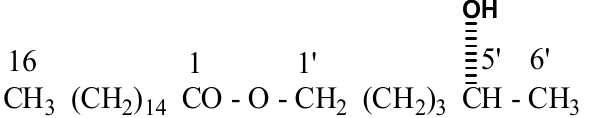
Scheme 1. Isolated compound 5 (cid:48) -hydroxyhexyl n-hexadecanoate (AB Scheme. 1. Isolated compound 5 ′ -hydroxyhexyl n-hexadecanoate (AB 01).